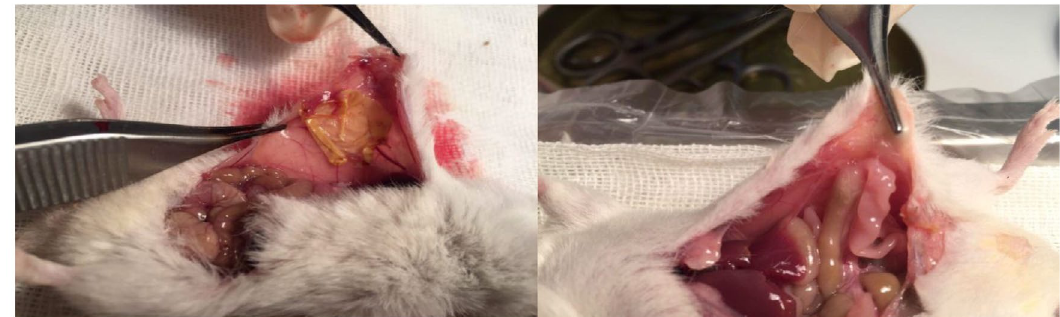
Fig. 7. Adhesion in Mice model, A) Cur-PCL nanofibers as anti-adhesion barrier, B) induced postsurgical adhesion in mice